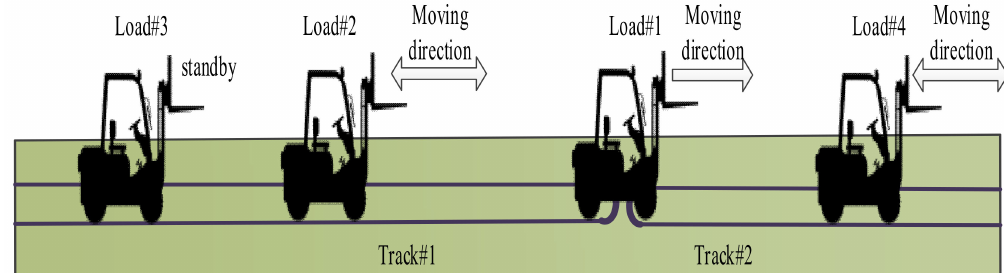
Figure 4. Dynamic analysis